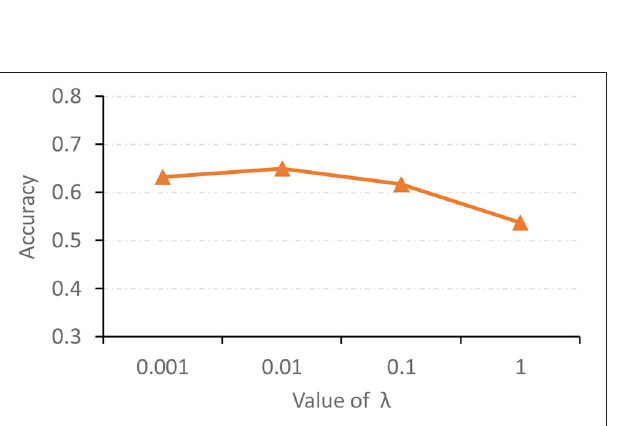
FIGURE 4 | Performance of our AMNI and its three variants in the task of MDD vs. HC classification, with best results shown in bold.